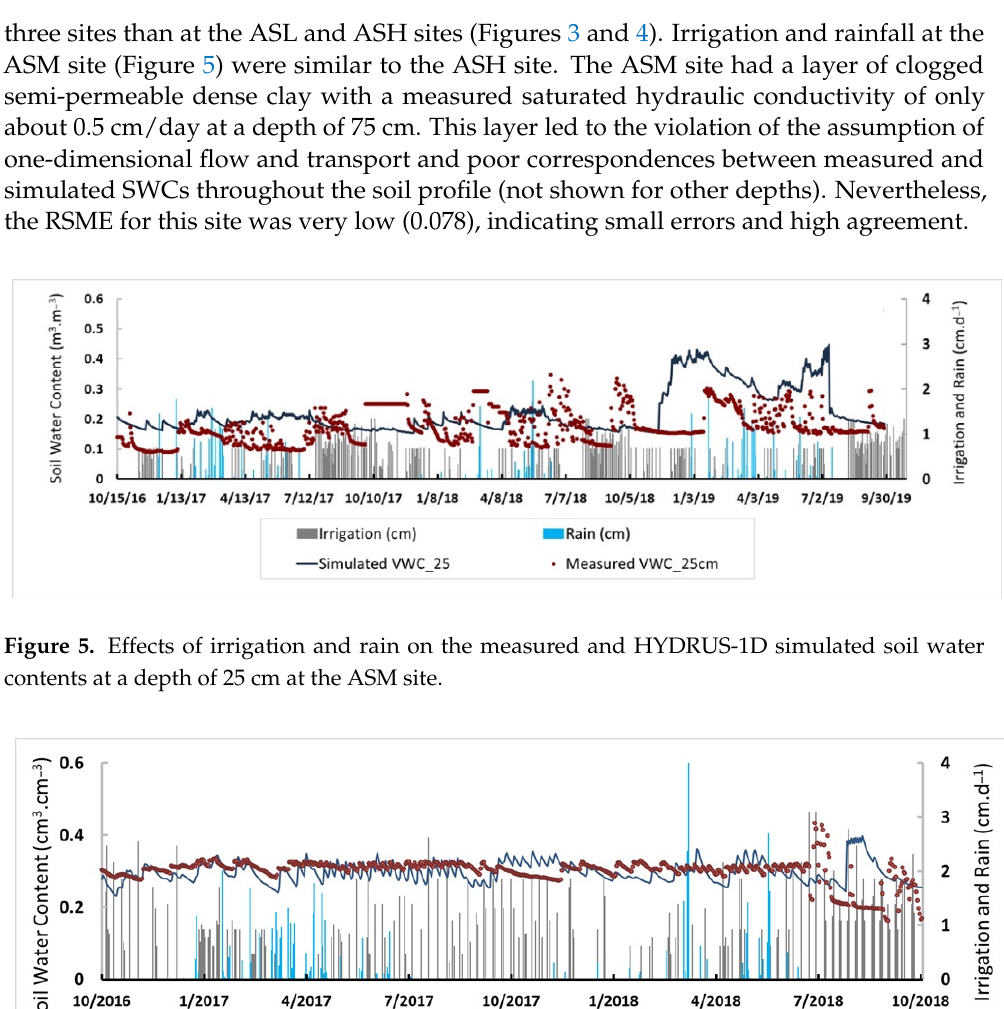
Figure 4. Measured (dots) and simulated (lines) soil water contents at four root zone depths of 25, 50, 75, and 100 cm at the ASH site.